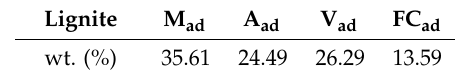
Table 2. Proximate analysis of raw